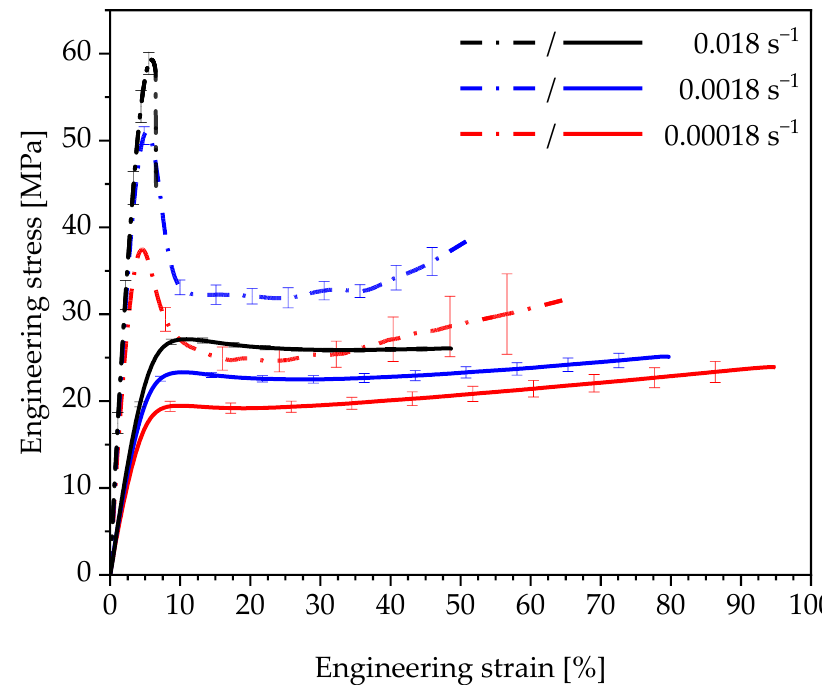
Figure 2. Strain-rate-dependent stress – strain curves of Neukadur ® ( — ) and puroclear ® (- · -) under uniaxial tensile load (type 1A test specimens according to DIN EN ISO 527-2).